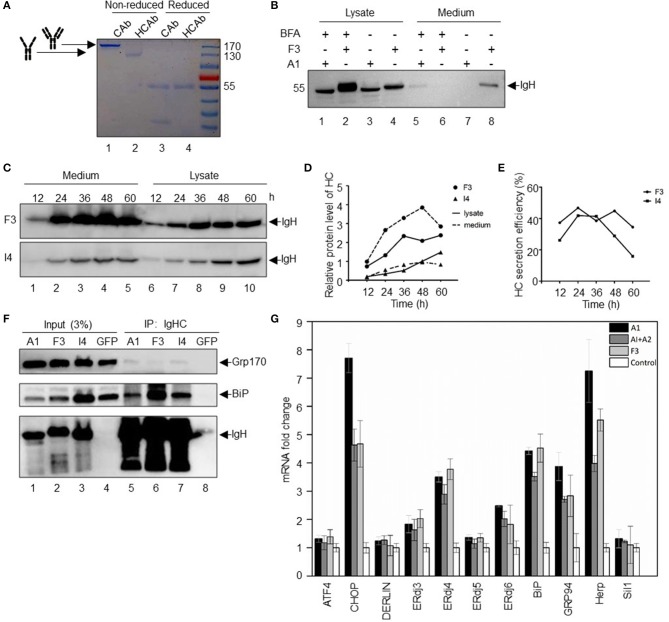
Expression and secretion of SLE HCAbs. (A) Secretion forms of HCAbs and conventional antibodies. Reduced with DTT and non-reduced with no DTT, stained with Coomassie brilliant blue after SDS-PAGE. (B) SLE HCAbs are assembled and transported through the ER-Golgi protein transport and secretion pathway. BFA is brefeldin A, a vesicle-mediated protein transport inhibitor from ER to Golgi. (C–E) Changes in the protein expression and secretion of HCAbs within 60 h. F3 is a HCAb with high protein expression and secretory efficiency, while I4 is relatively weaker in both aspects. (F) HCAbs bind to BiP and GRP170 to varying degrees. The binding ability of heavy chain to important chaperone molecules of the endoplasmic reticulum was analyzed by an immunoprecipitation assay. F3 and I4 are HCAbs, and A1 is a conventional IgH. (G) Expression of HCAbs, IgH, or conventional antibodies induced different endoplasmic reticulum gene expression. Fluorescence quantitative real-time PCR was used to analyze the expression of important genes involved in protein folding, assembly and degradation in the endoplasmic reticulum after 24 h of transfection of different constructs (mean ± s.e.m., n = 3 independent experiments). A1 is a non-secretory IgH, A2 is an IgL, and F3 is an HCAb IgH.